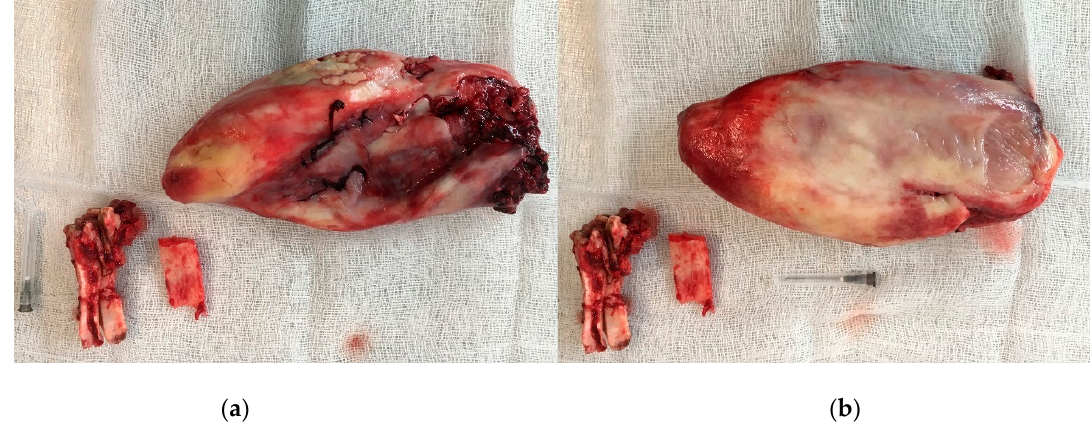
Figure 6. Extracted Triadan 208, fragment of the nasal bone, excised mass: ( a ) lateral site, ( b ) medial site. The skin and subcutaneous tissues were sutured as previously described (Figure 7). Part of the mass was sent for histopathological examination.